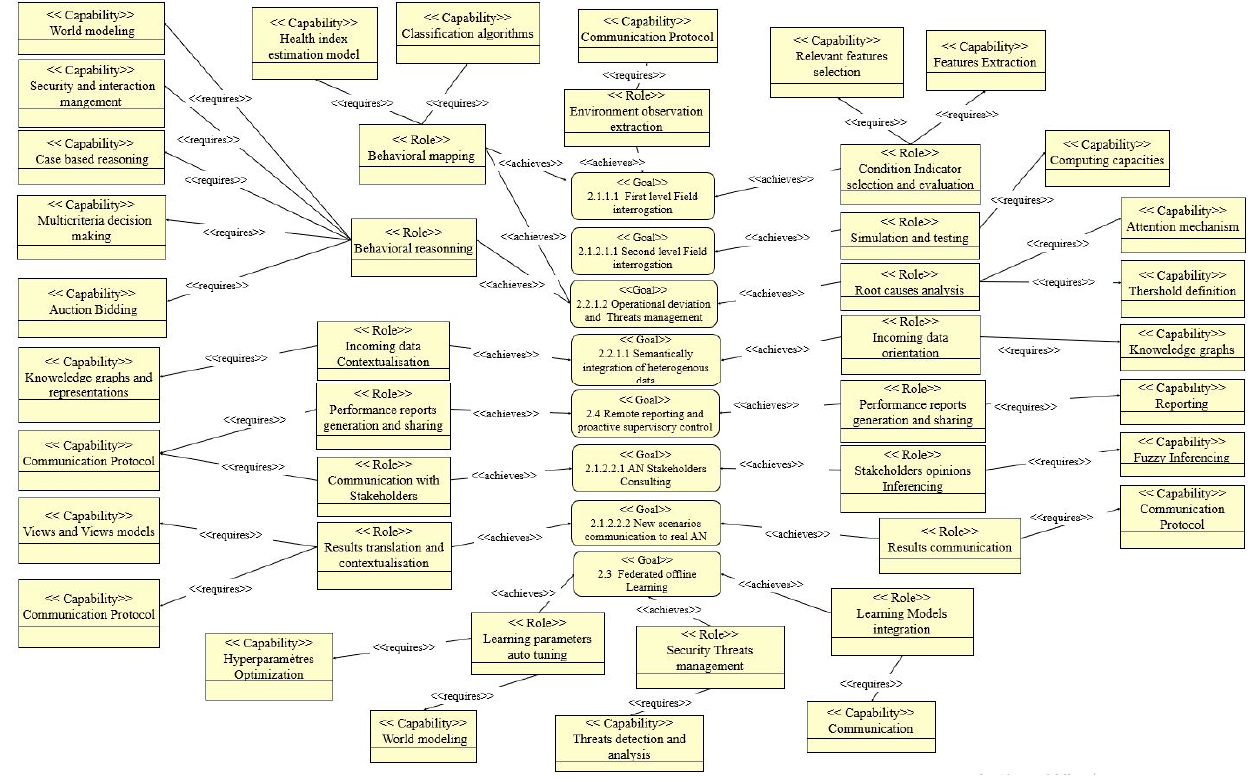
Figure 4. HT OMASE information view example for the use case—goal–role–capability model.